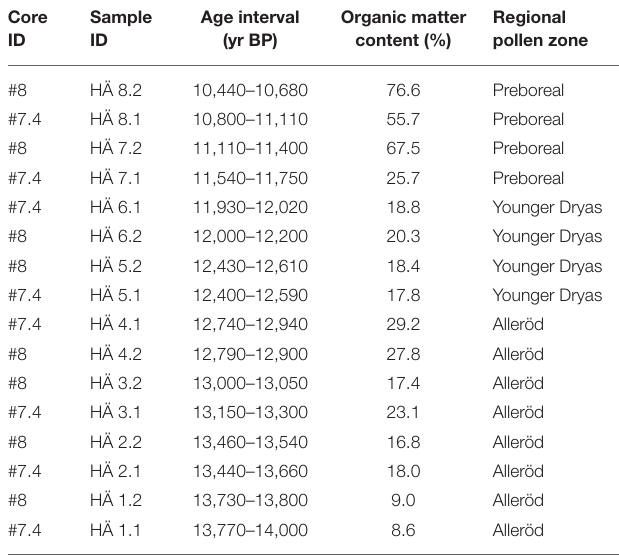
TABLE 1 | The 16 samples analyzed for eDNA, pollen, and plant macrofossil remain in cores #7.4 and #8, their age interval, organic matter content, and their assignment to the regional pollen